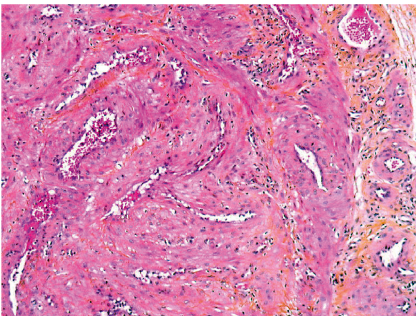
Figure 3: At higher magnification, the tumor consists of spindle cells with eosinophilic cytoplasm and blunt nuclei, forming fas- cicles surrounding the vessels with thick muscular walls (hema- toxylin-eosin-saffron stain, original magnification: × 250).